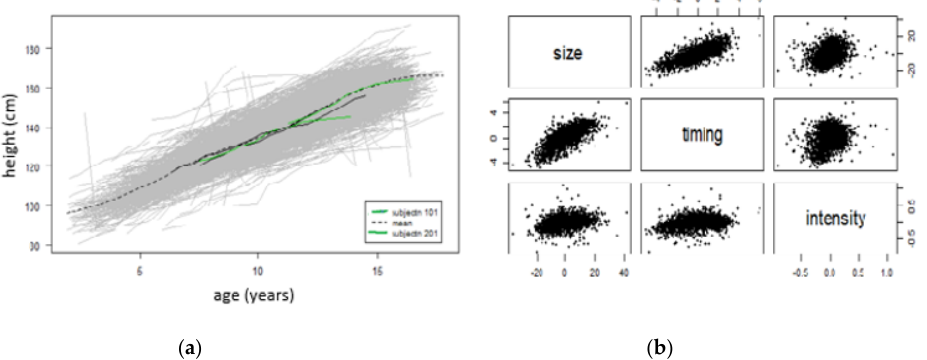
Figure 4. E ff ects of SITAR adjustment in individual curves for both boys and girls. E ff ects of SITAR adjestment in individual curves, ( a ) shows the curves in gray as background, plus for the tallest and shortest children before and after adjustment, along with the mean curve (dashed line). For children, subjectn 101 and 201 ( b ) mean height is estimated as 4.4 and 19.3 cm less and greater than average (size) respectively, age at peak height velocity is 1.3 and 4.2 years earlier than average (timing), and mean growth rate is 1.14% and 18% (intensity) respectively. SITAR: Superimposition by Translation and